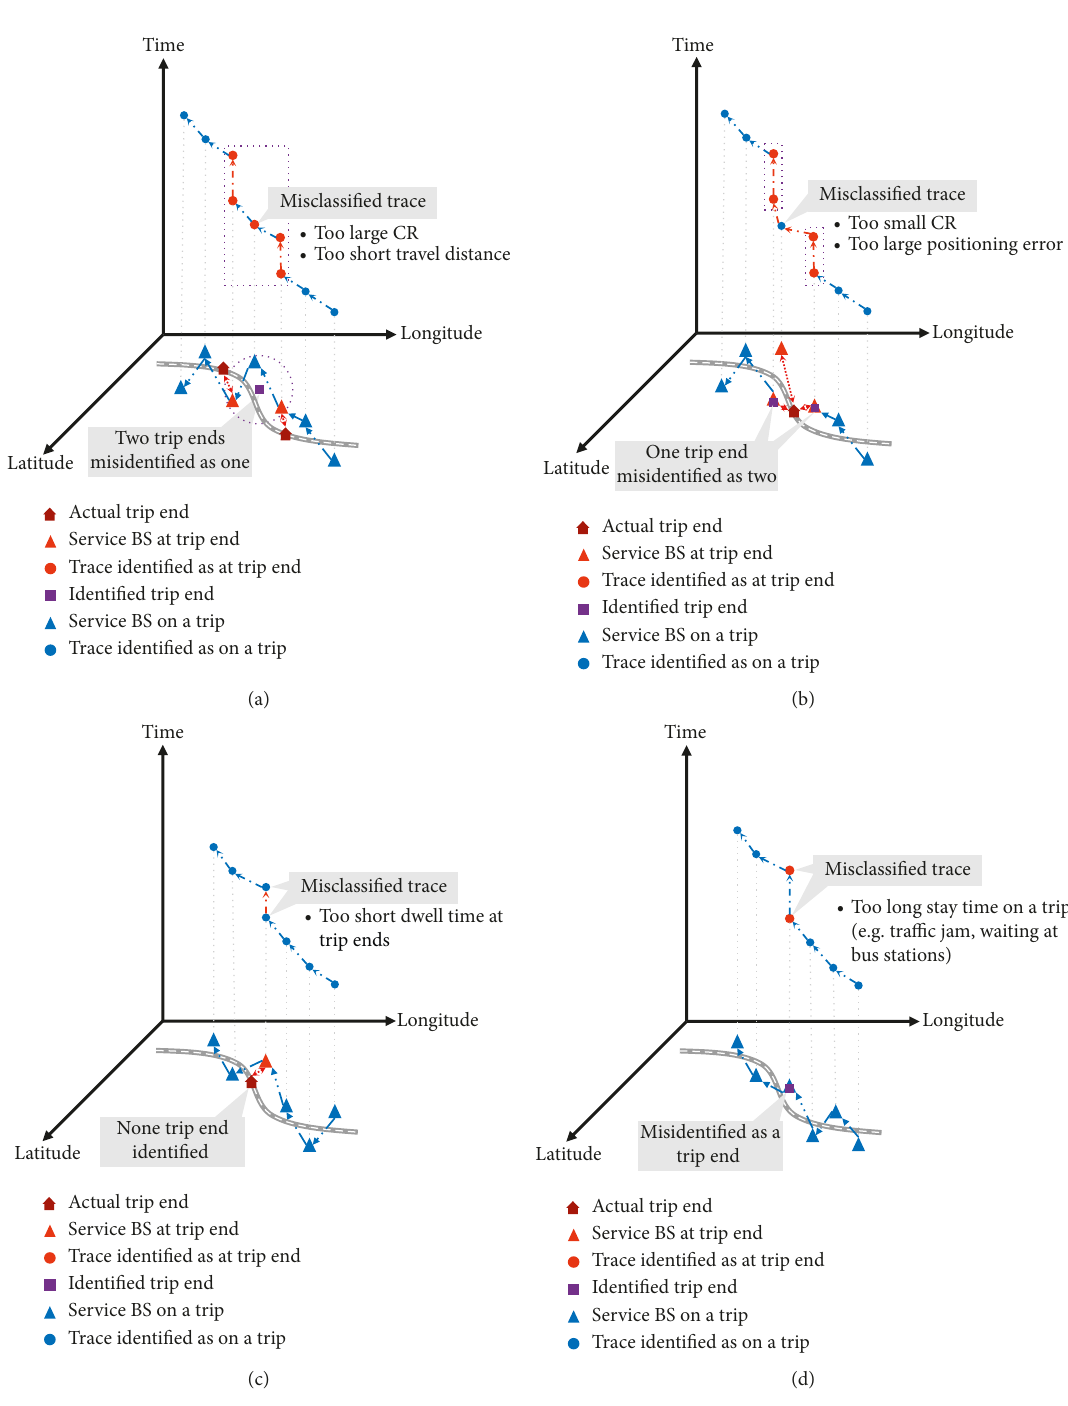
Figure 4: Diagrams of misidentification for trip ends. (a) Merged identification. (b) Segmented identification. (c) Not identified. (d) Additional